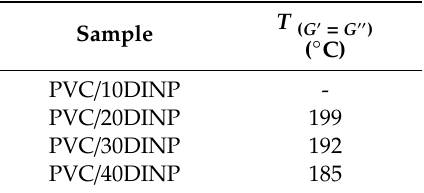
Table 3. Cross-over (G (cid:48) = G (cid:48)(cid:48) ) temperatures, T ( G (cid:48) = G (cid:48)(cid:48) ) , for printable formulations obtained at frequency of 1